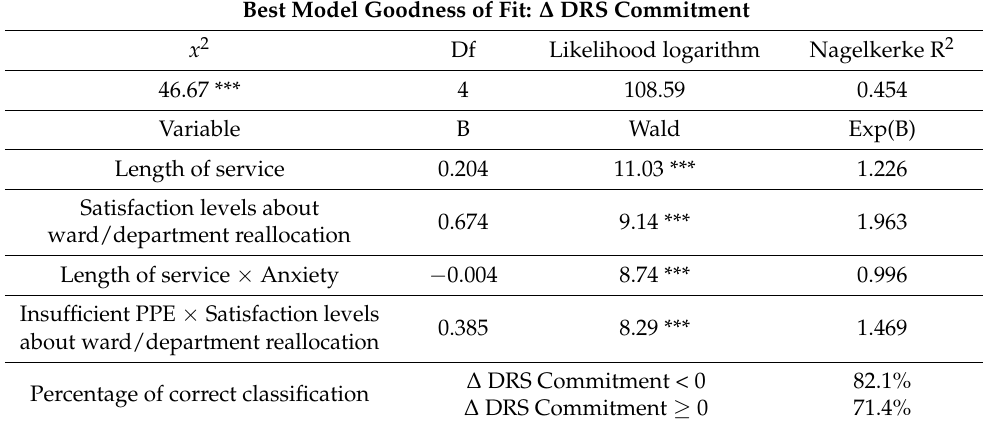
Table 20. Commitment predictors according to multivariate analysis (length of service, transfer evaluation, length of service × anxiety, and insufficient PPE (no) × transfer evaluation) and cor- rect/incorrect classification of the model.